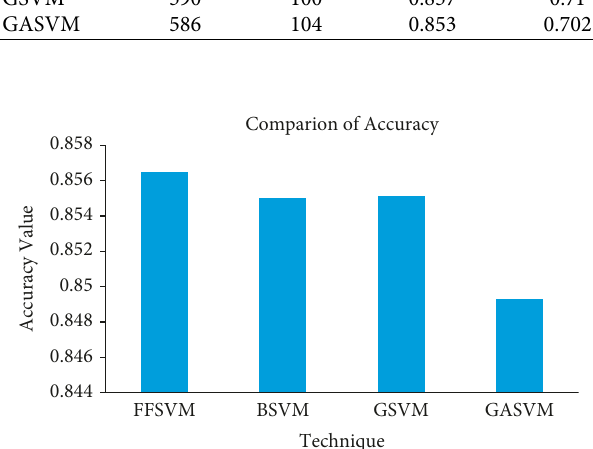
Figure 2: Classification accuracy comparison between the pro- posed algorithm and three other search algorithms (BSVM, GSVM, and GASVM) for fraud detection which shows the proposed al- gorithm to be the most accurate.